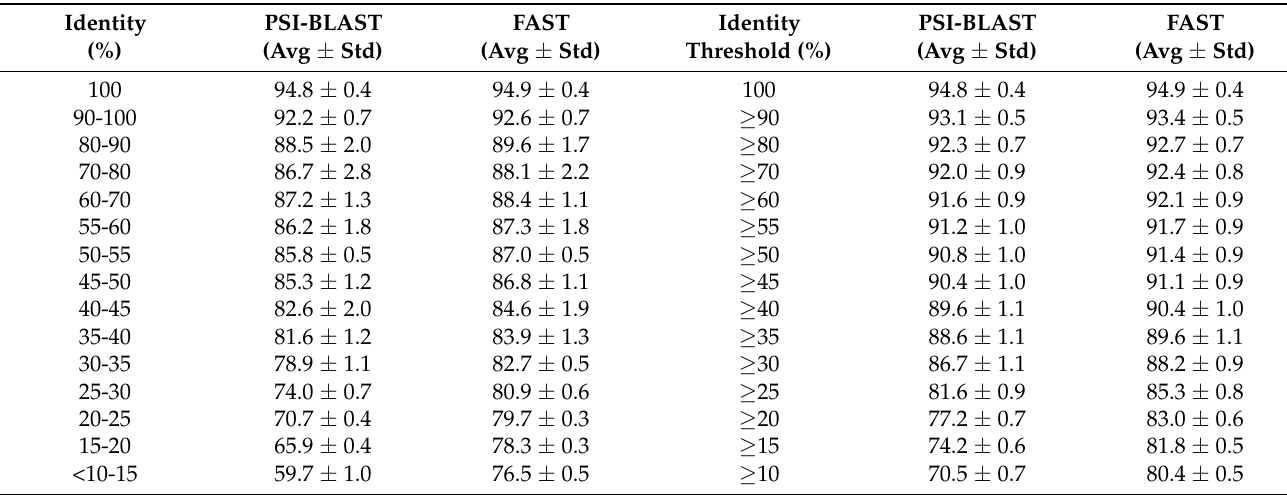
Table 3. Eight-state secondary structural consistency measured by sequence/structure alignments for homologs identified from